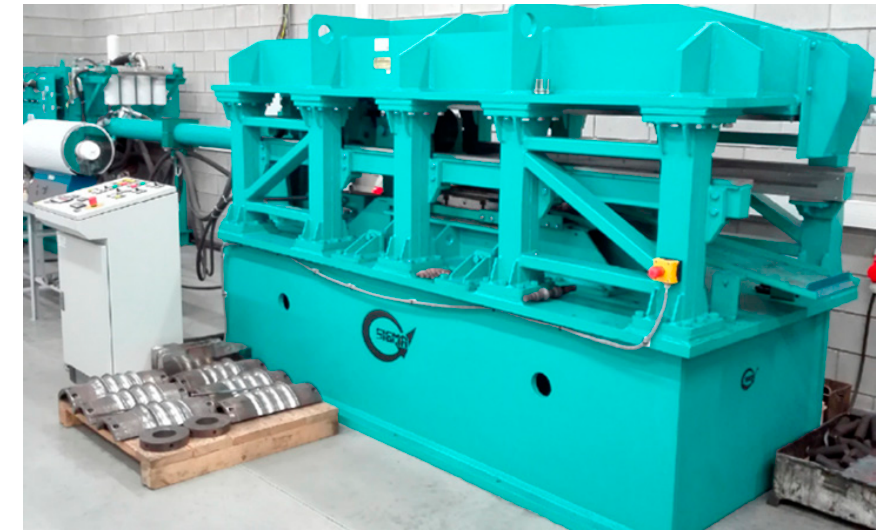
Figure 2. Cross-wedge rolling mill used in experimental testing.